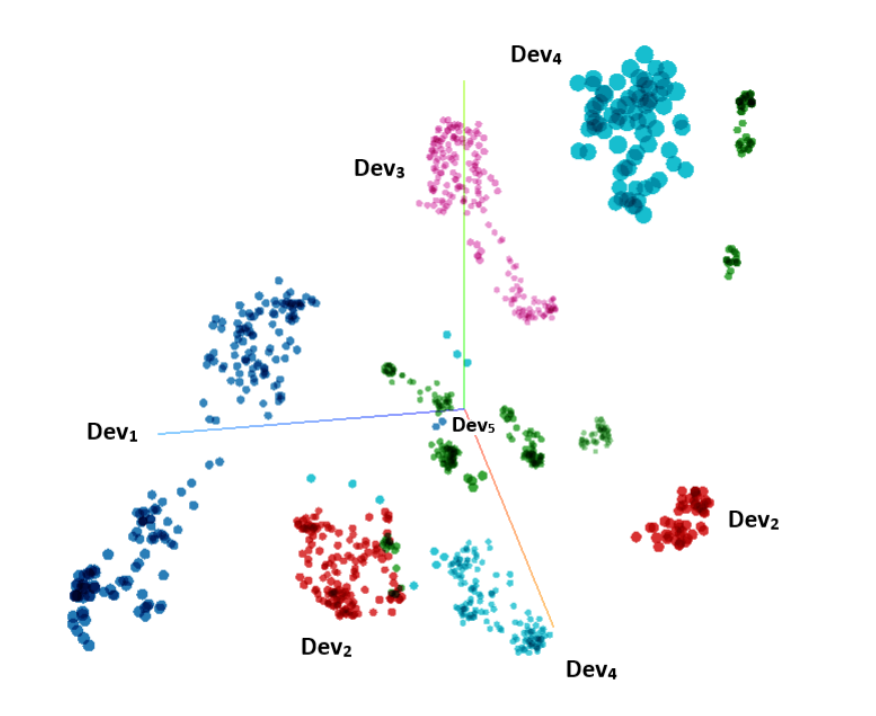
Figure 2. T-SNE visualization for the subset of five developers, unigram features and doc2vec vector size of 300.